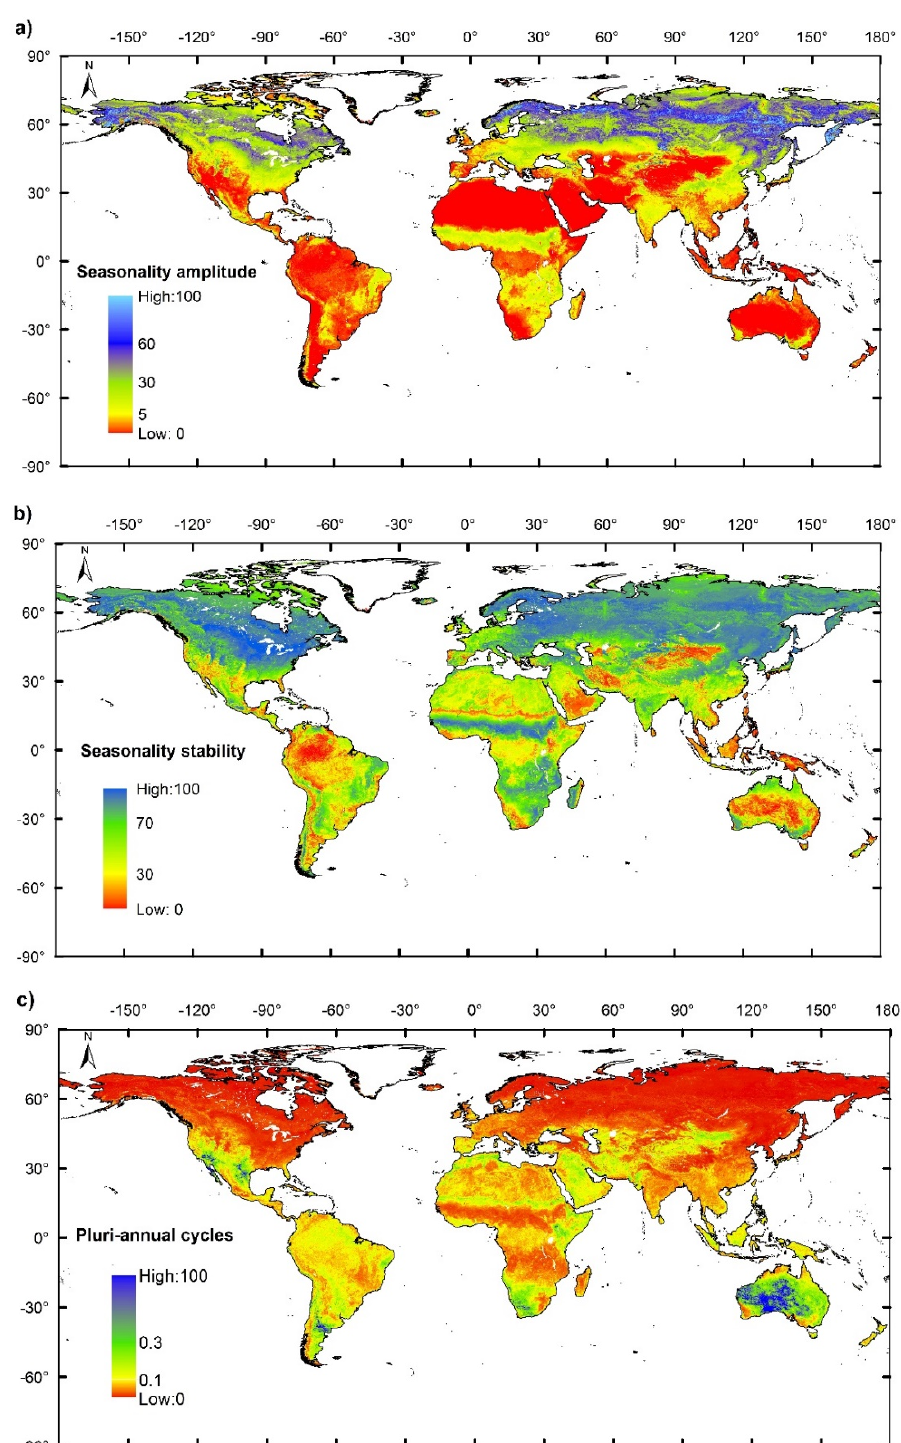
Figure 3. ( a ) Seasonality amplitude, ( b ) seasonality stability and ( c ) pluri-annual cycles indicator of NDVI time series.